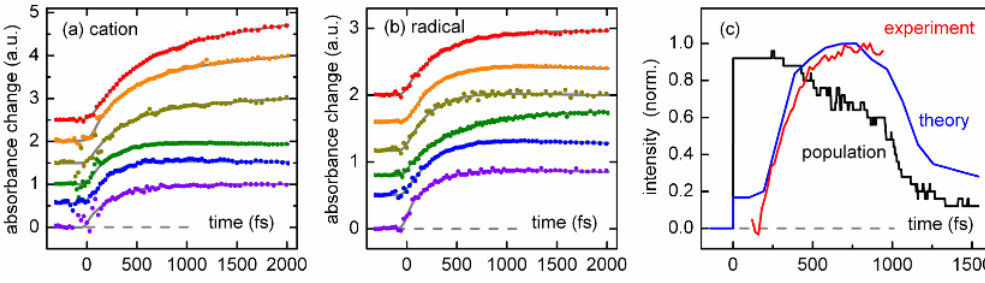
Fig. 2. After UV excitation, many combinations of diphenylmethylchloride derivatives and solvents, a generic ~300 fs rise time constant for the transient absorption of (a) the benzhydryl cation and (b) the benzhydryl radical is found. (c) On-the-fly MD simulations on a benzhydryl cation directly after bond cleavage and surrounded by a solvent shell can reproduce the signal rise independent from the actual cation population. The signal rise can be attributed to a relaxation / planarization of the nascent